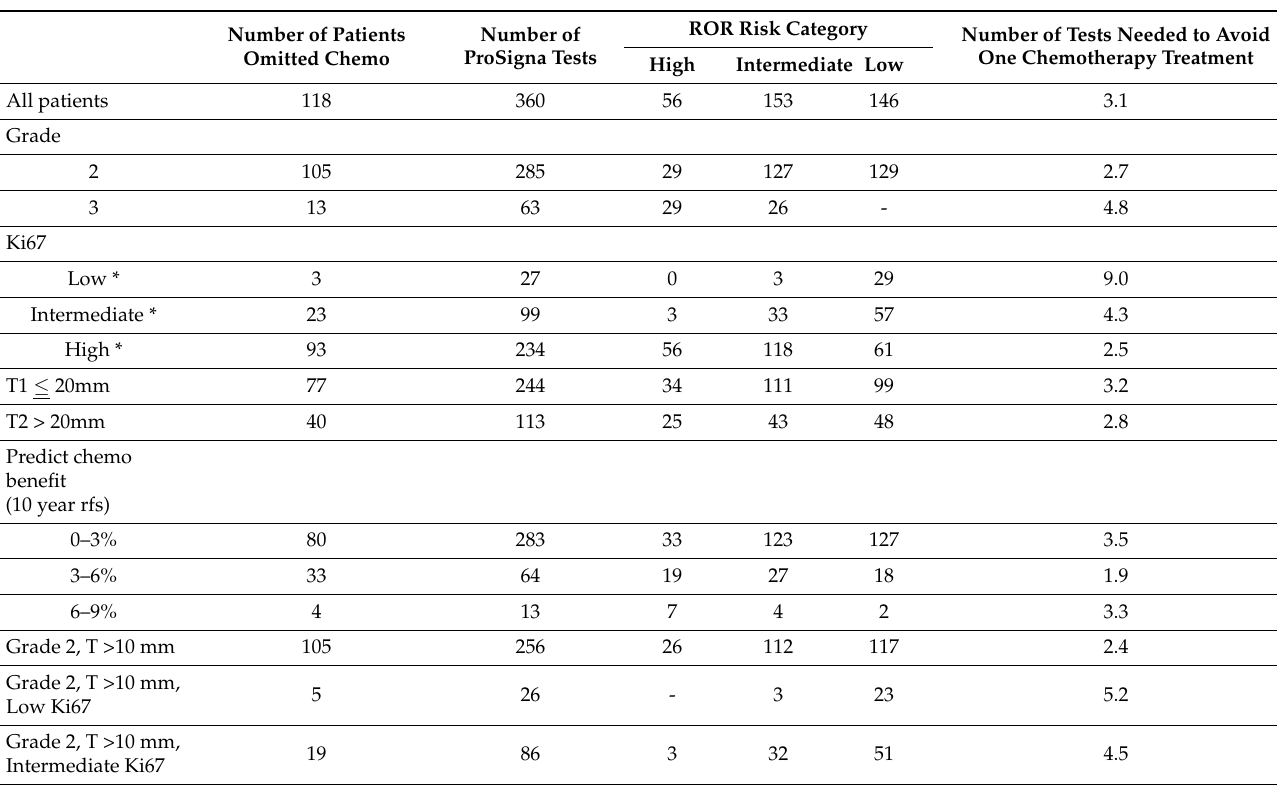
Table 4. Number of tests required per omitted adjuvant chemotherapy per tumor characteristic (tumor grade, proliferation Ki67and T tumor size) and additional benefit of chemotherapy (%) on 10-year recurrence-free survival (rfs) based on NHS Predict score. * Ki67 pathology lab specific limits are presented in Table